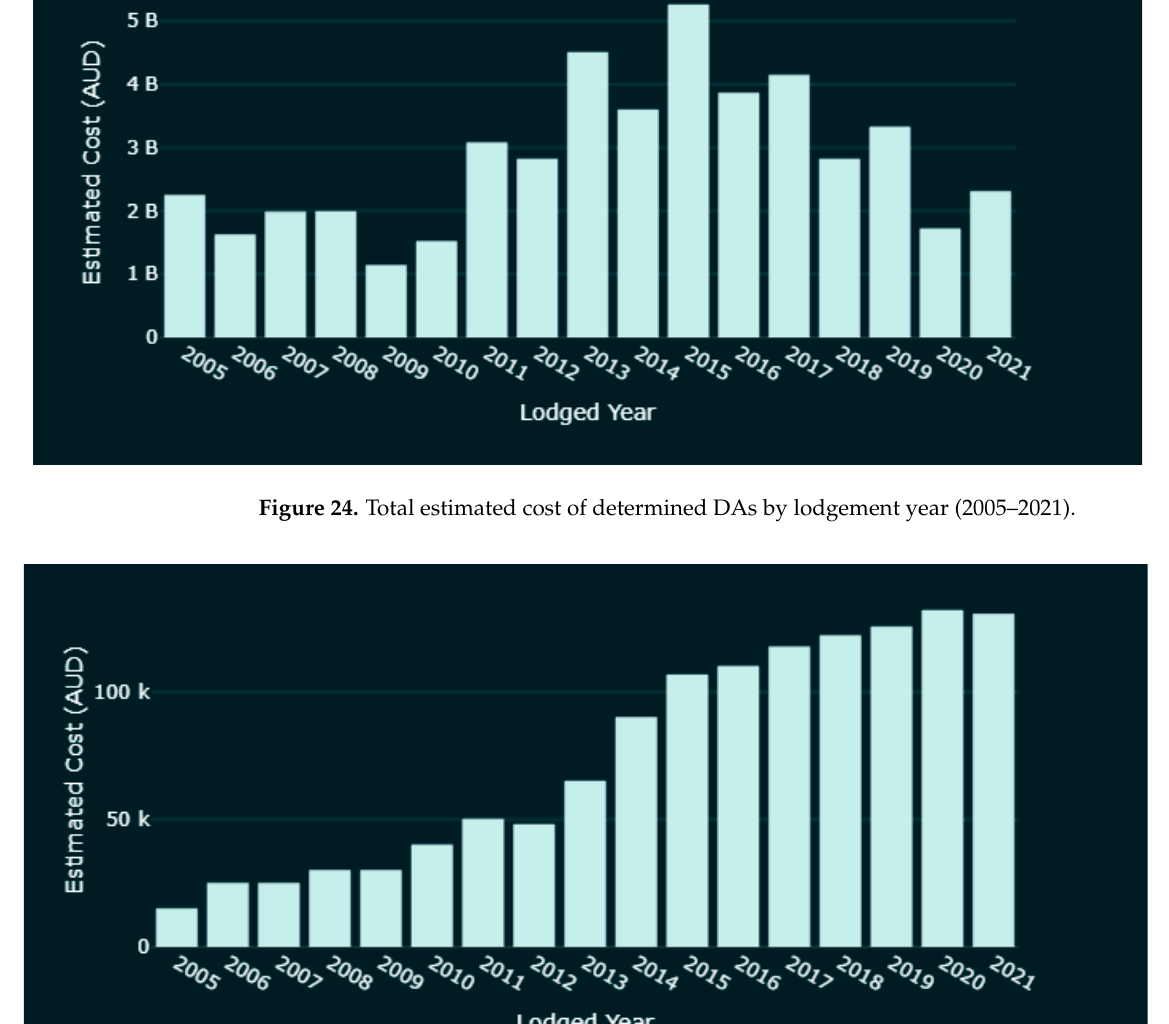
Figure 25. Median estimated cost of determined DAs by lodgement year (2005–2021).